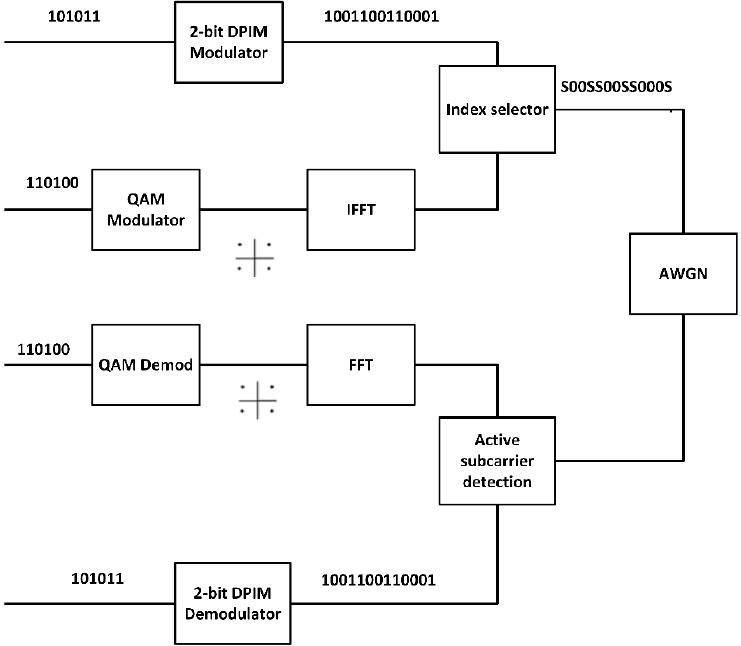
Figure 7. Simulation setup used to obtain SNR vs CNR curve. At the transmitter end, two-bit streams are generated. One is modulated using a DS-PIM modulator, while the other is modulated through a QAM modulator. IFFT is then performed on the QAM-modulated bit stream. The resulting QAM symbols are assigned specific indices within the subgroup, corresponding to the indices of 1’s in the DPIM modulated symbol. The signal is then passed through an AWGN noise source.